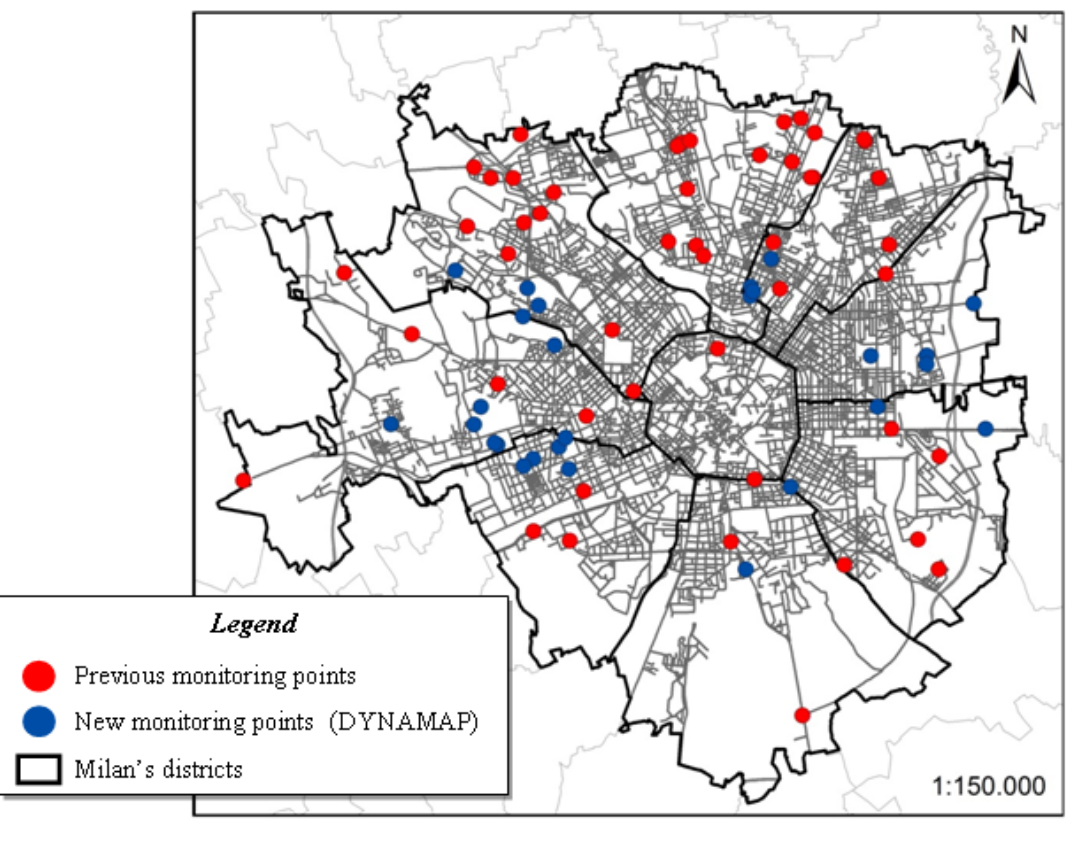
Figure 3: The location of noise measurements positions.